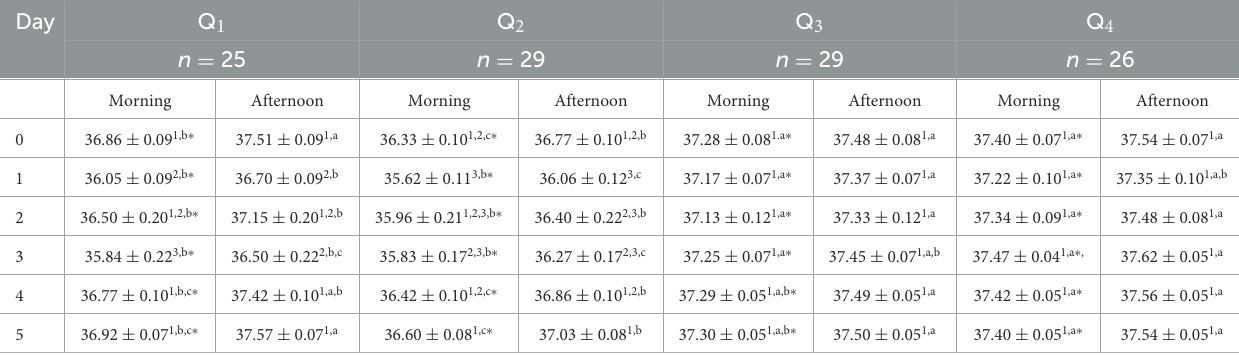
TABLE 6 Mean lacrimal gland surface temperature ± standard error (SE) in 109 newborn water buffaloes at different birth weights and daytimes (morning/afternoon) during the first 6 days of life. Day Q 1 Q 2 Q 3